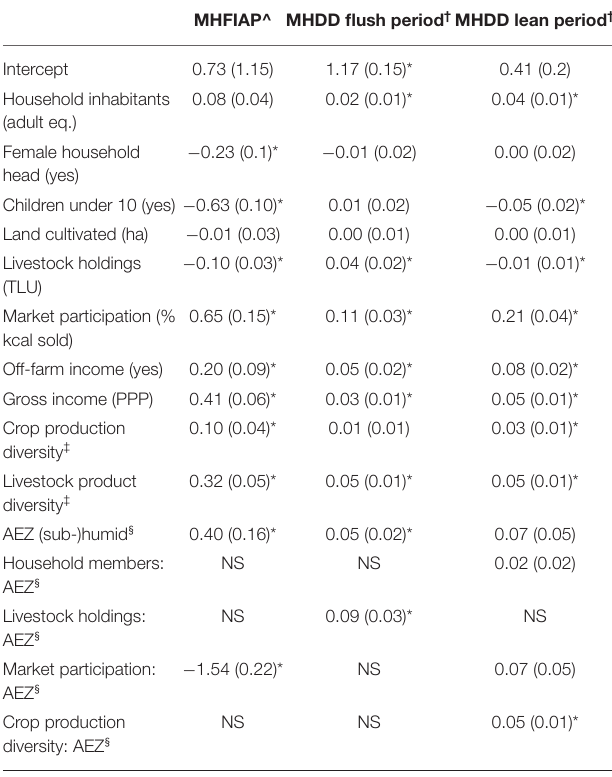
TABLE 2 | Associations between food security indicators (dependent variables in columns) and livelihood characteristics and agro-ecological zone